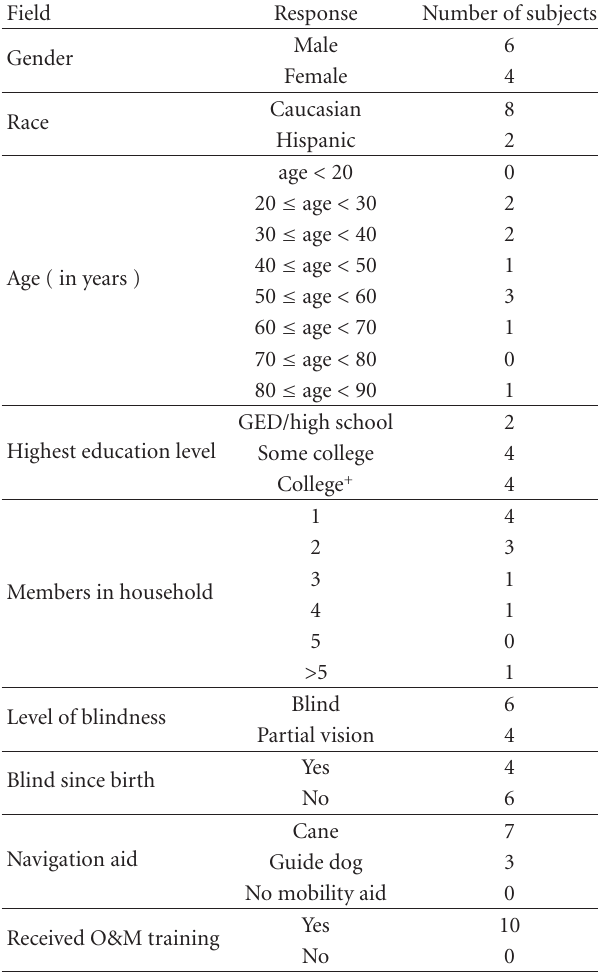
Table 1: Population for Phase I